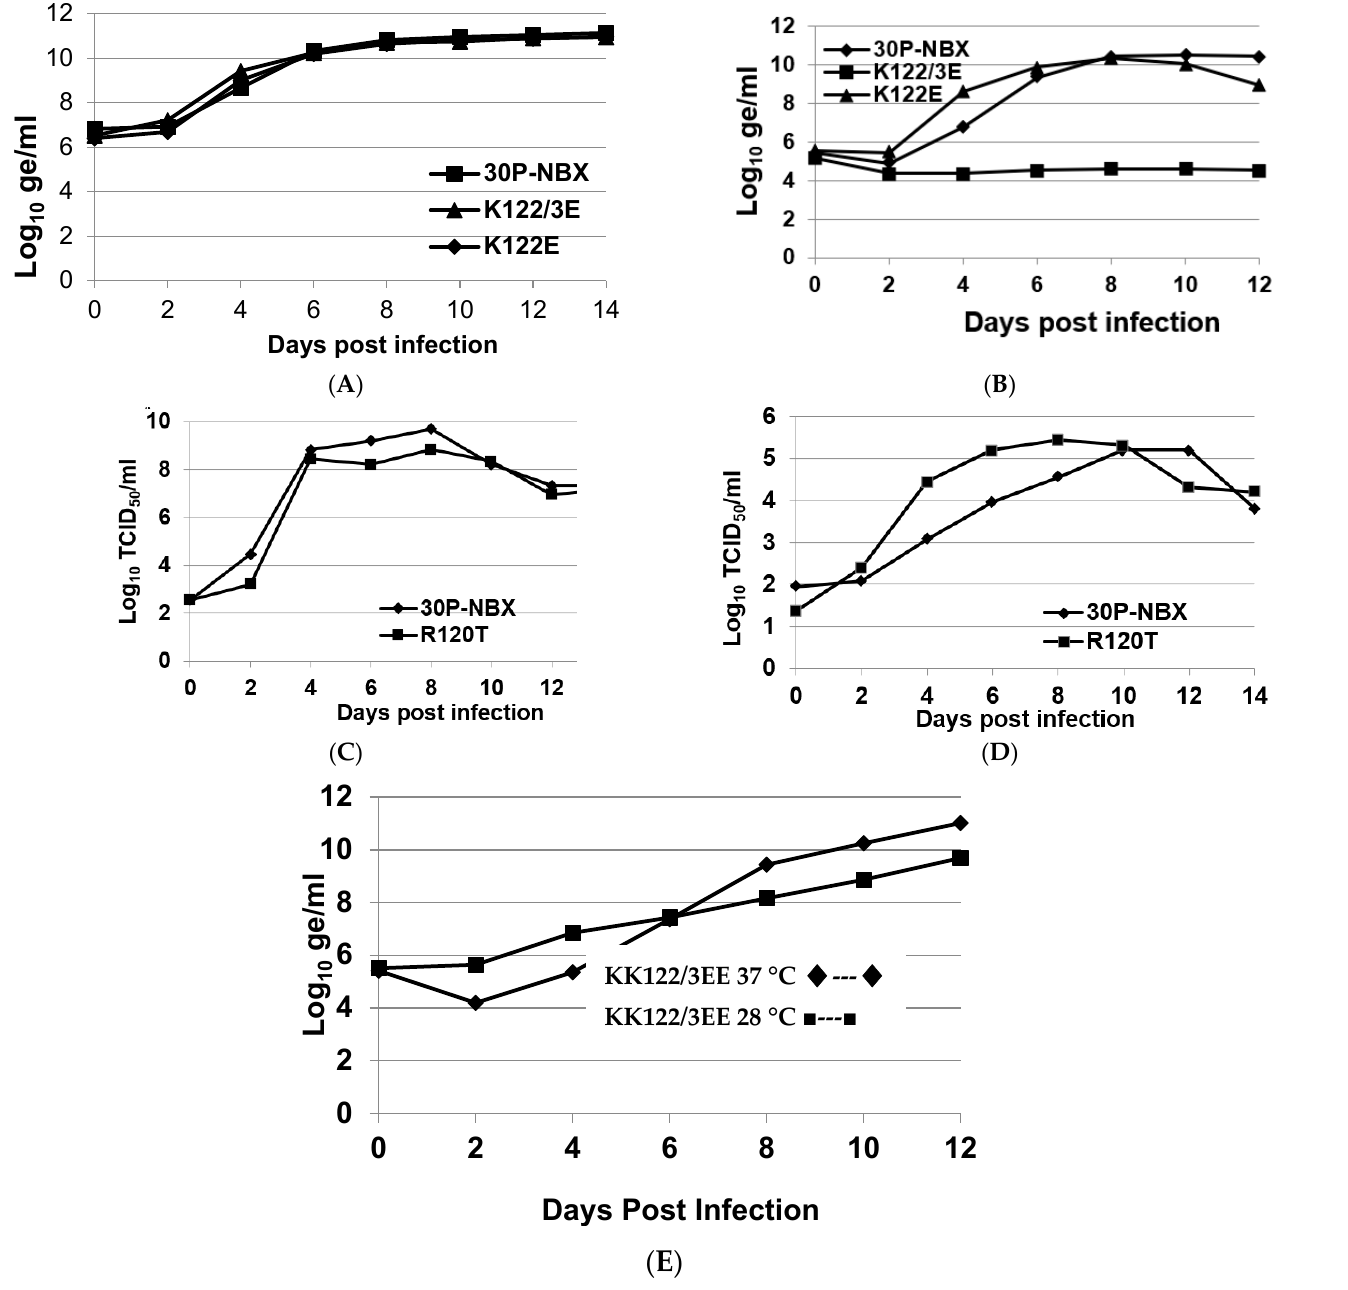
Figure 3. Virus growth kinetics in C6/36 and Vero cells. C6/36 cell cultures at 28 ◦ C ( A ) and Vero cell cultures at 37 ◦ C ( B ) were infected with DENV2s at an MOI of 0.001 and medium was sampled every two days for 14 or 12 days. Data presented are geometric mean titers (in log 10 genome equivalents/mL) from duplicate flasks determined by RT-qPCR. C6/36 cell cultures at 28 ◦ C ( C ) and Vero cell cultures at 37 ◦ C ( D ) were infected with 30P-NBX and R120T at a MOI of 0.001 and infectious virus in medium was measured by TCID 50 every two days for 14 days. The data presented are geometric means (in log 10 TCID 50 / mL ) from duplicate flasks. ( E ) Duplicate Vero cell flasks were infected with mutant KK122/123EE and maintained at 37 ◦ C or 28 ◦ C. Titers were determined by RT-qPCR. Virus RNA was sequenced at the end of the growth curve to verify the status of engineered mutations. Mutant KK122/123EE retained the mutated sequence at 28 ◦ C but the sequence partially or fully reverted to E123 at 37 ◦